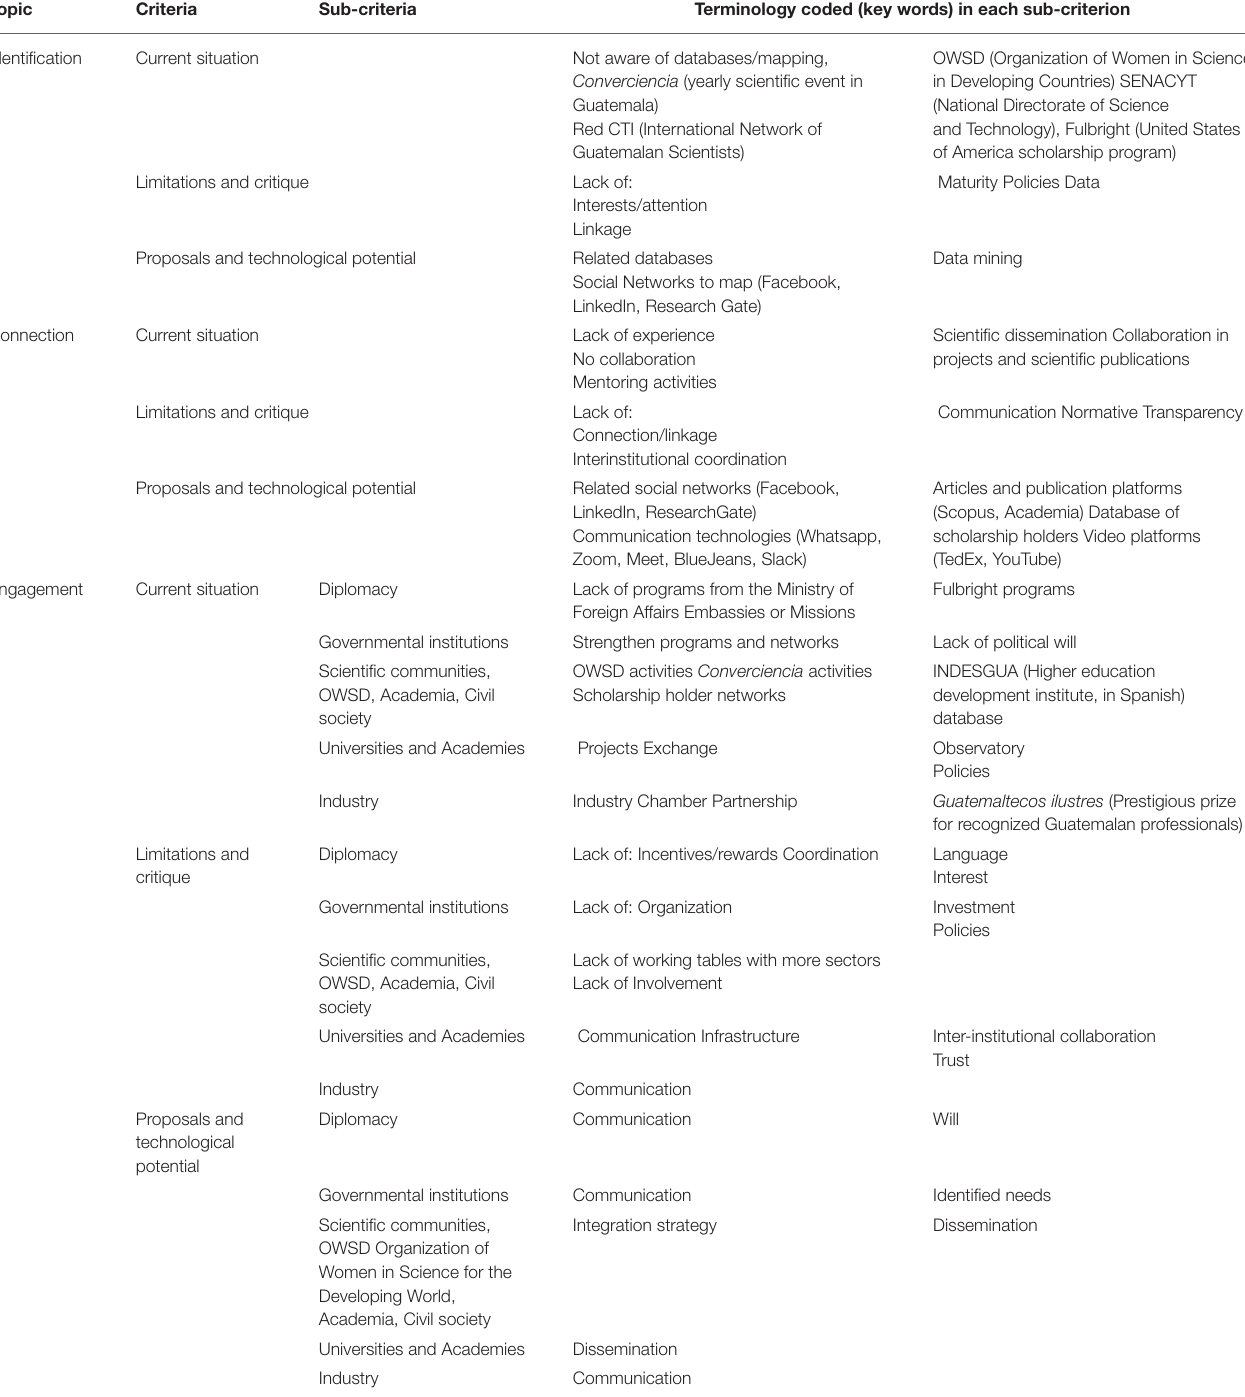
TABLE 5 | Topic criteria and sub-criteria for data